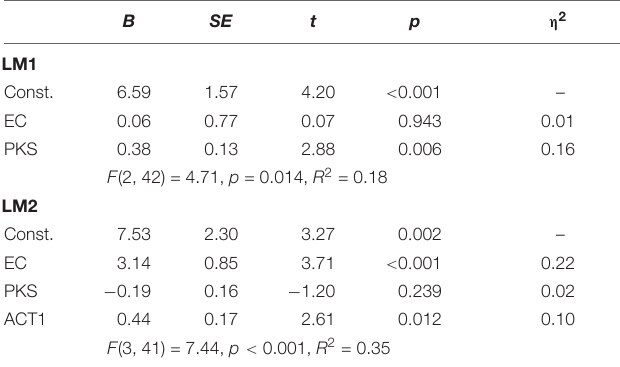
TABLE 3 | Regression results for LM1 and LM2, Study 1.